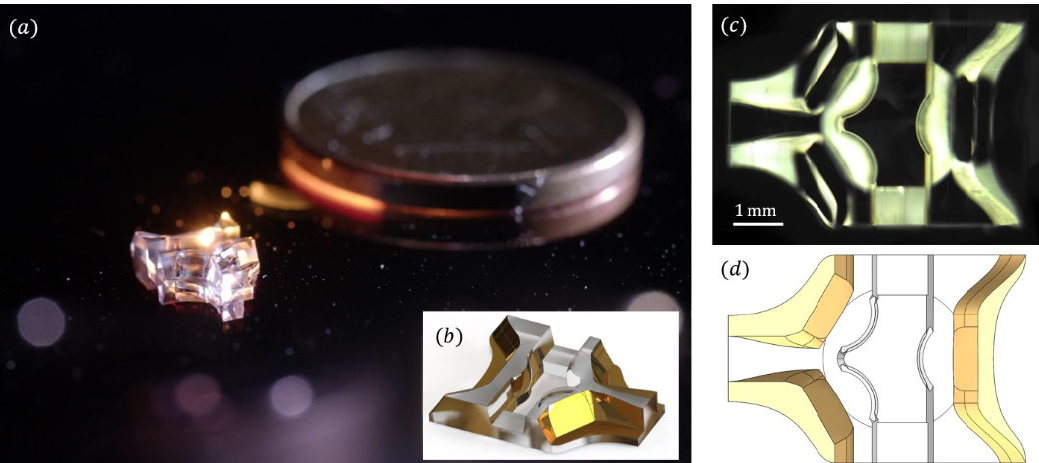
Figure 12. ( a ) Photography of the fabricated optical system next to a one ‐ euro cent coin. ( b ) 3D view of the optical system. ( c ) Optical view of the fabricated glass piece. ( d ) Associated view of the original drawing.